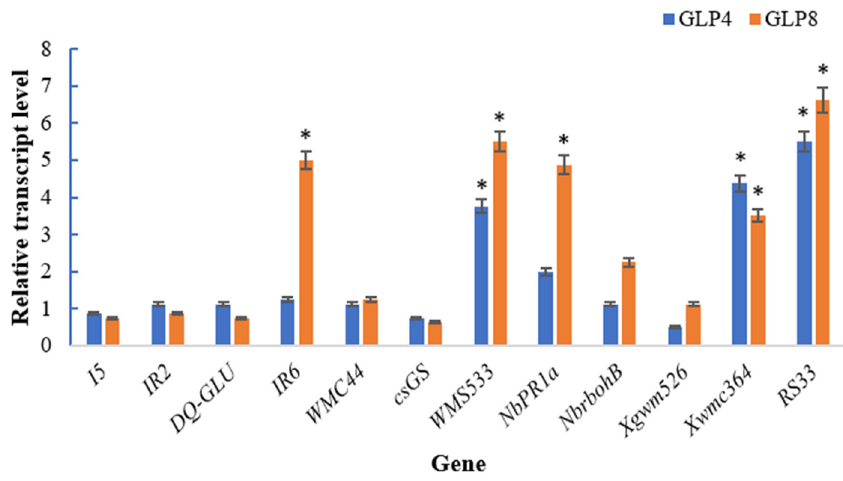
Figure 3. Effect of seed treated GLP on transcript quantity of wheat (Jimai 22) disease resistance- related gene. GLP 4: 4% GLP, GLP 8: 8% GLP. * indicates significant difference at 0.05 level.